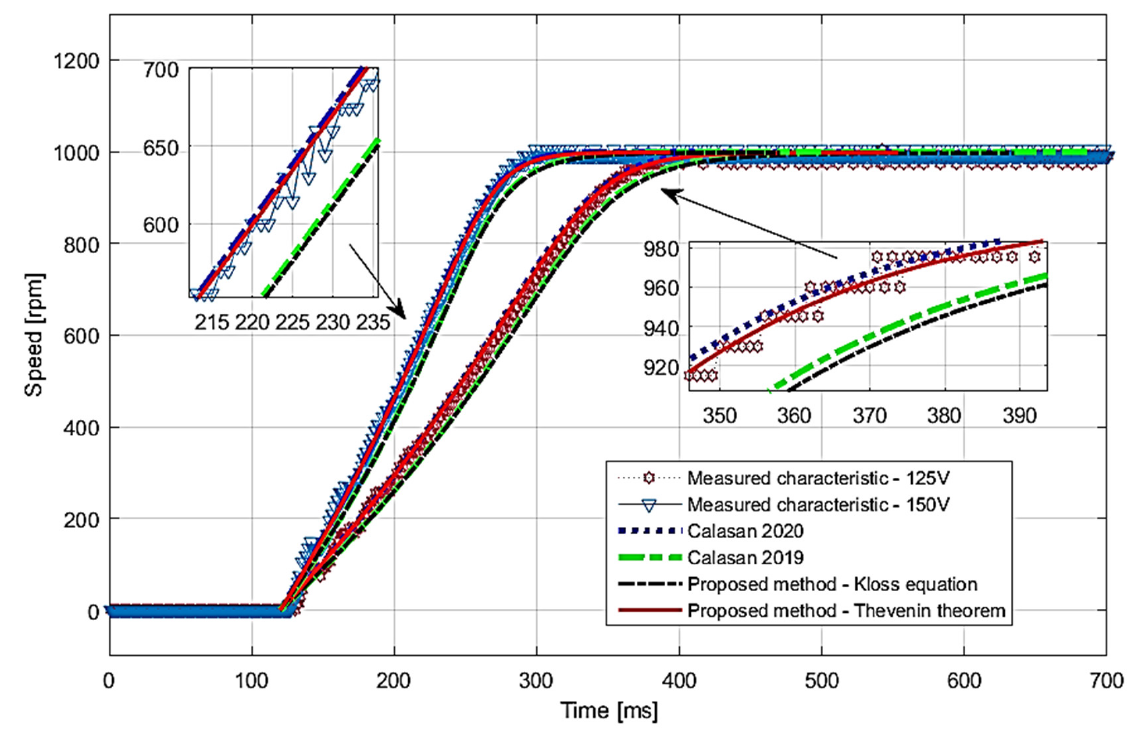
Figure 6. Measured and simulated speed-time characteristics of IM#2.